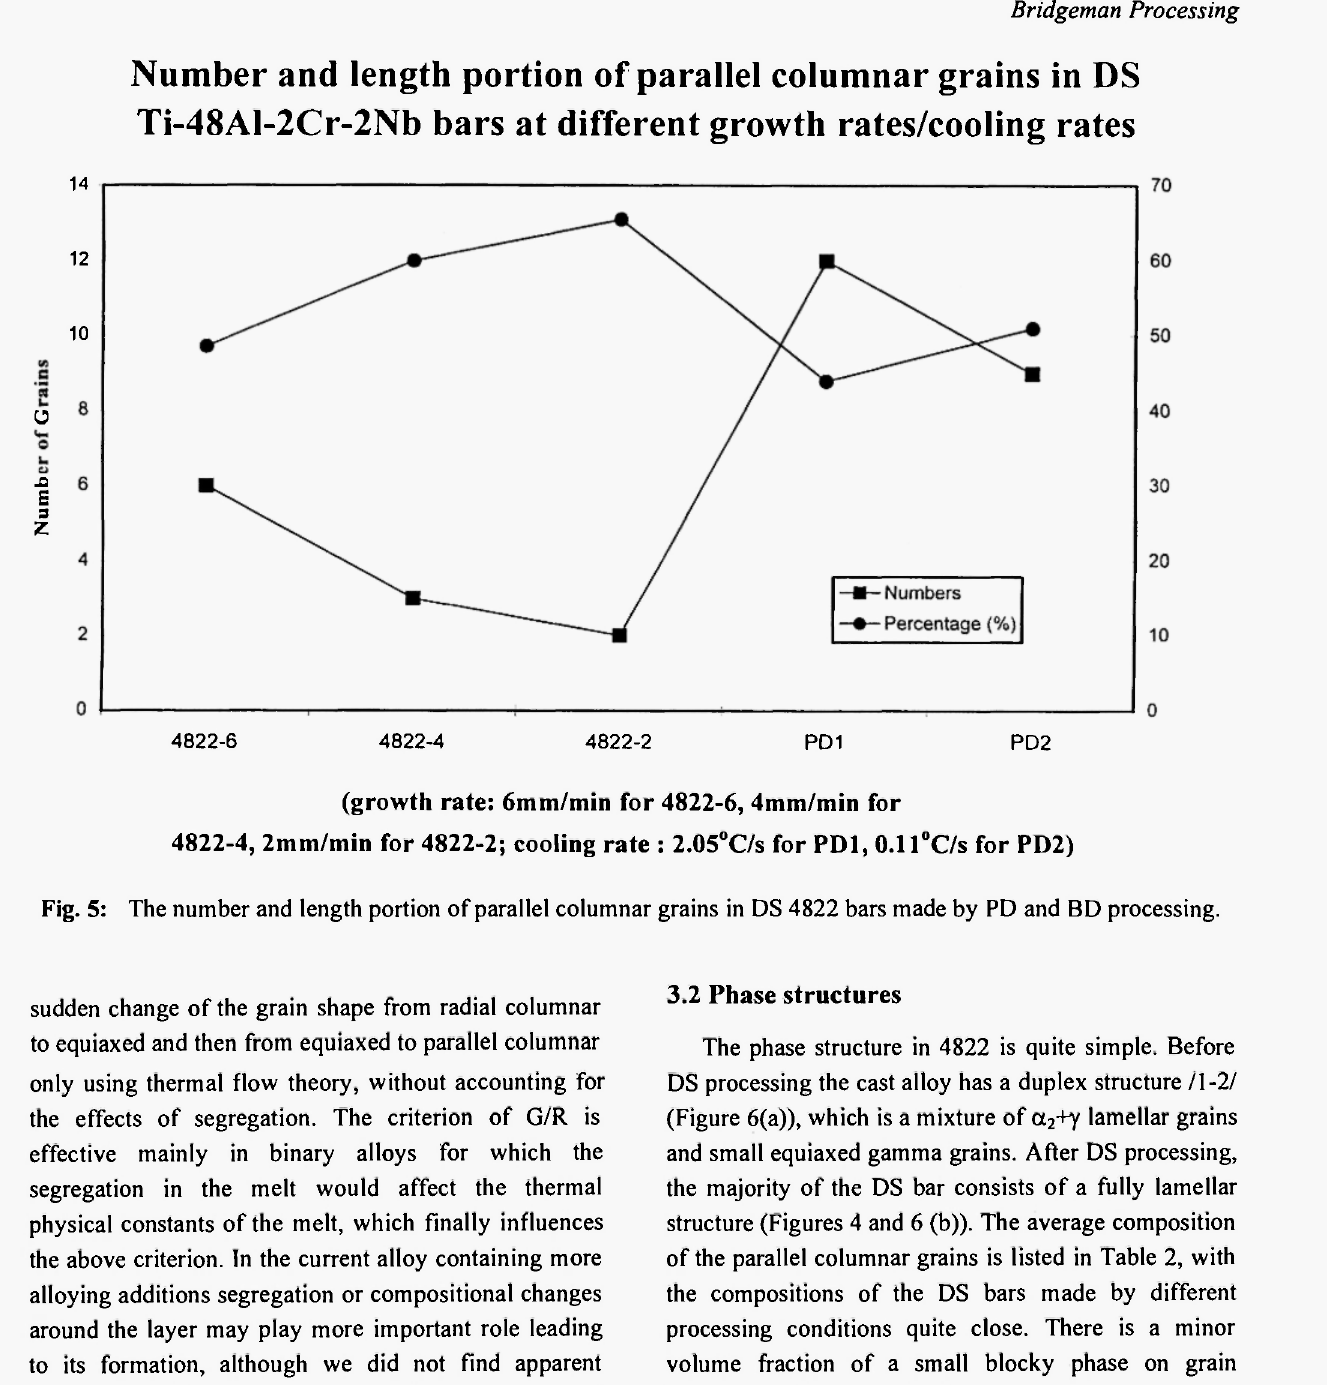
Fig. 5: The number and length portion of parallel columnar grains in DS 4822 bars made by PD and BD processing.